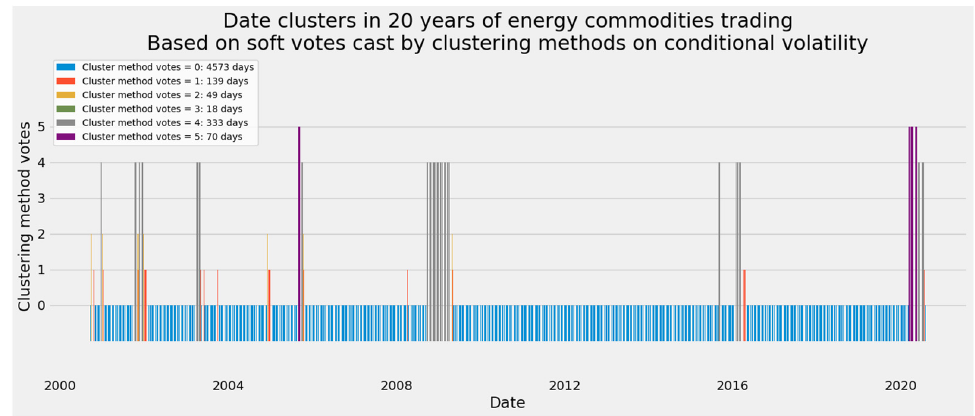
Figure 37. A voting-based aggregation of temporal clusters and critical periods in energy-related commodities trading—An ordered timeline.